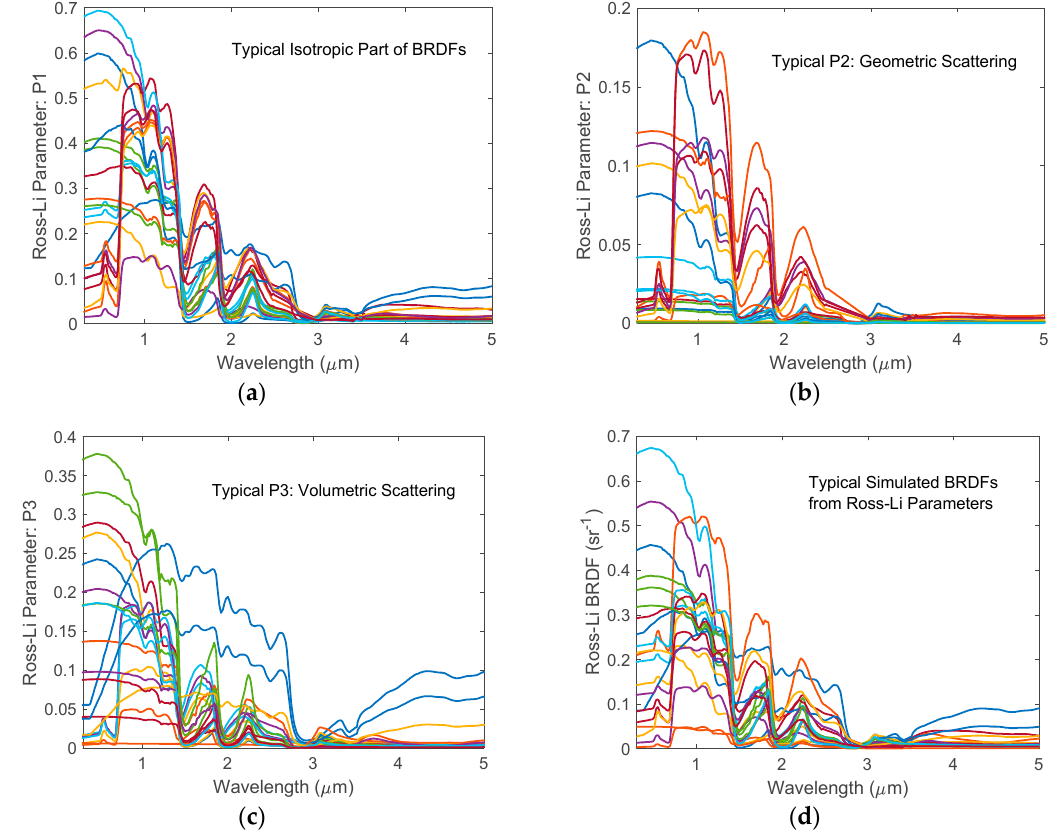
Figure 2. Typical Ross-Li parameters selected from 20,000 simulated samples. ( a ) Isotropic parts of the BRDFs; ( b ) Coefficients of the Li-Sparse-Reciprocal geometric scattering kernel; ( c ) Coefficient for the Ross-Thick volumetric scattering kernel; ( d ) Typical BRDF spectra of the land surfaces obtained using Ross-Li BRDF parameters.